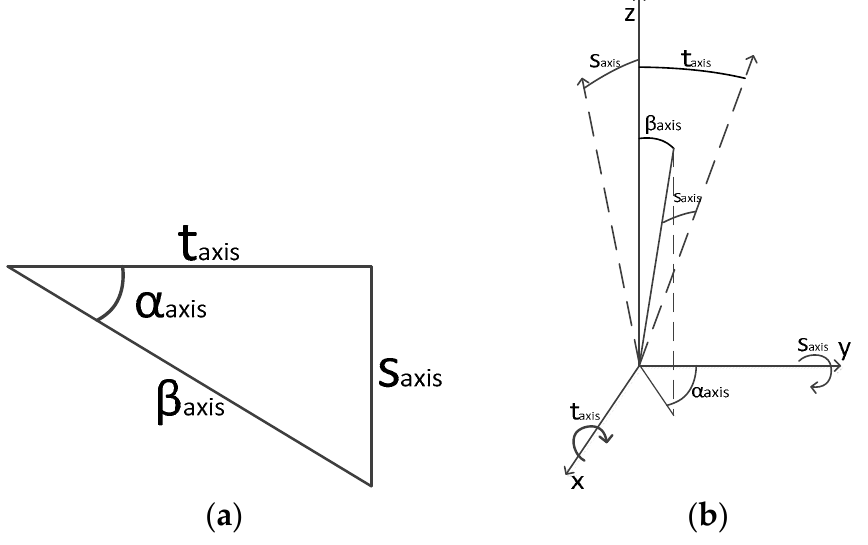
Figure 3. ( a ) Right triangle of the axis skew and ( b ) relation between the rotation of the axis and the skew of the rotation axis and its direction.